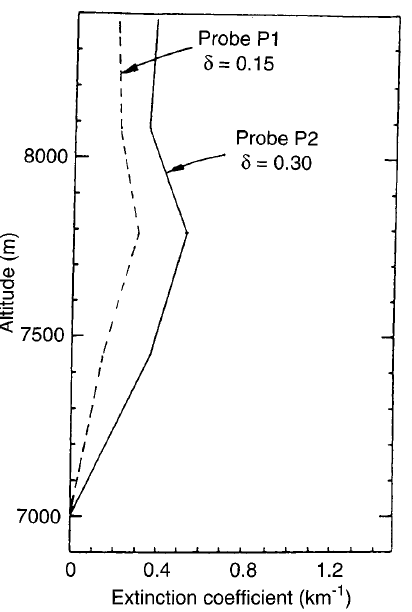
Fig. 8. Vertical profiles of the extinction coe(cid:129)cient at 1.06 mm deduced from measurements of two PMS 2D-C probes (P1, P2) during the sampling at di(cid:128)erent levels of a